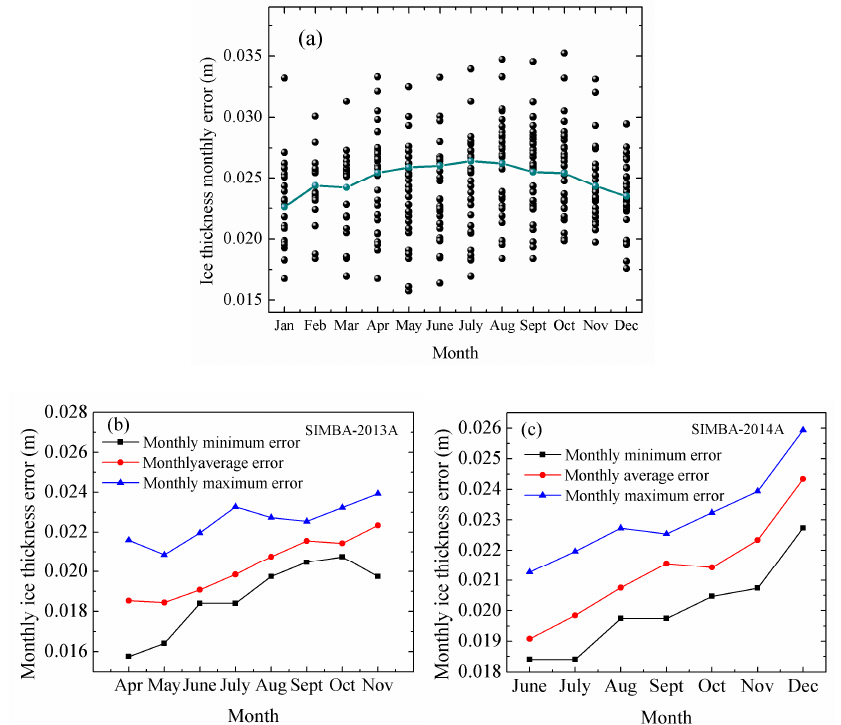
Figure 10. ( a ) Monthly error of ice thickness for Arctic sea ice. ( b , c ) Monthly error of ice thickness for Antarctic sea ice. Dark blue line represents average monthly error.